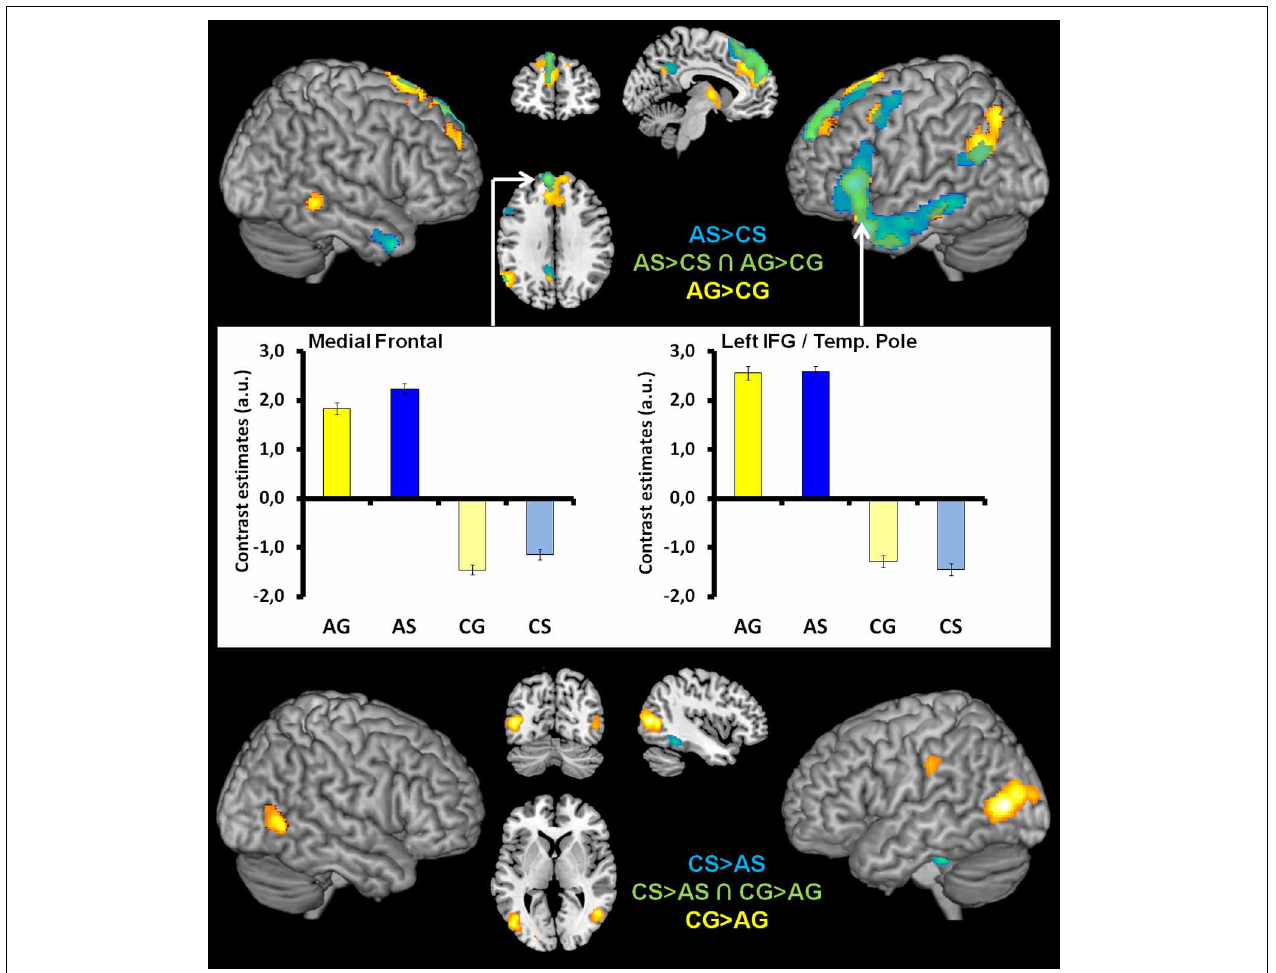
FIGURE 4 | Top illustrates the within-modality processing of abstractness in language semantics ([AS > CS], blue), gesture semantics ([AG > CG], yellow), and in common neural structures (green, overlapping regions). Bar graphs in the middle of figure illustrate the contrast estimates (extracted eigenvariates) for the commonly activated (green) medial superior frontal (left) and